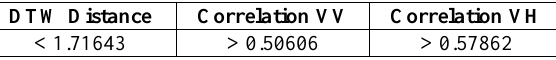
Table 4. Computed DTW parameters